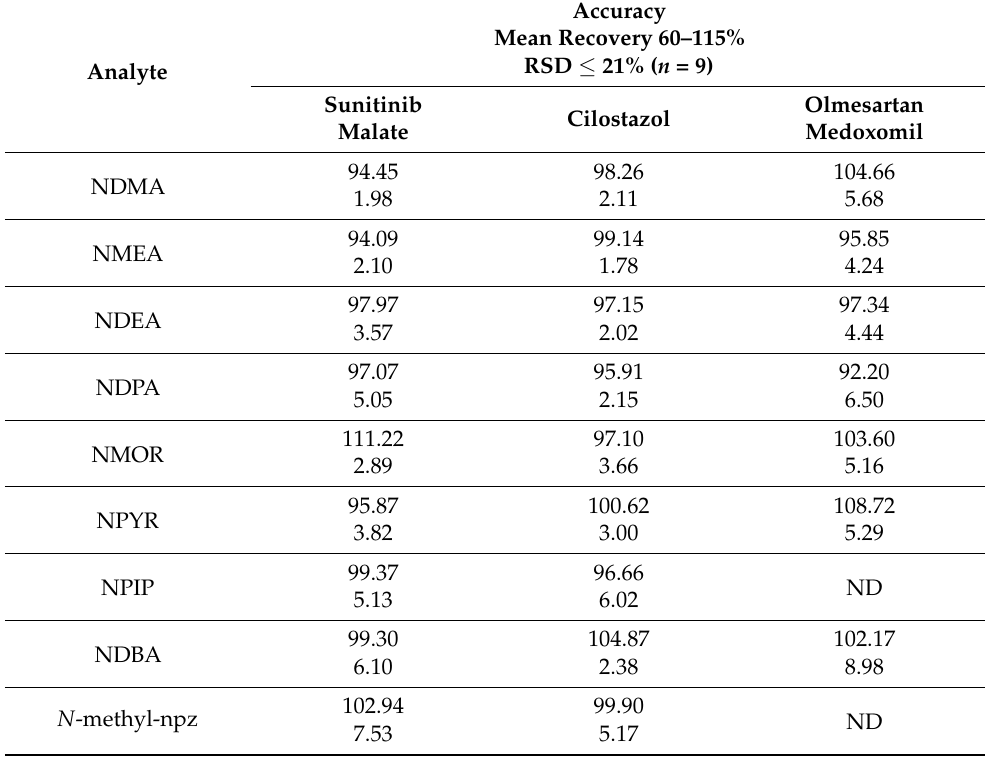
Table 2. Validation results of the accuracy for sunitinib, cilostazol, and olmesartan medoxomil.